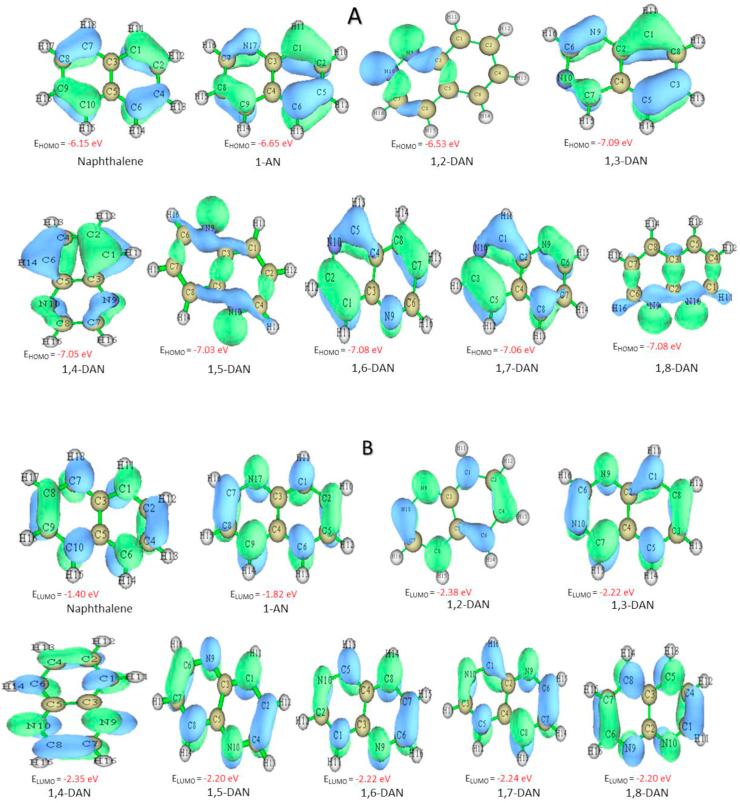
The isosurface of the HOMO (3A) and LUMO (3A) for Naphthalene, 1-AN, 1,2-DAN, 1,3-DAN, 1,4-DAN, 1,5-DAN, 1,6-DAN, 1,7-DAN and 1,8-DAN showing their respective Energy.